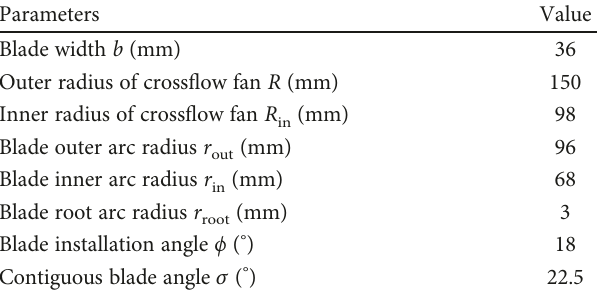
Table 2: Cross fl ow fan blade geometric